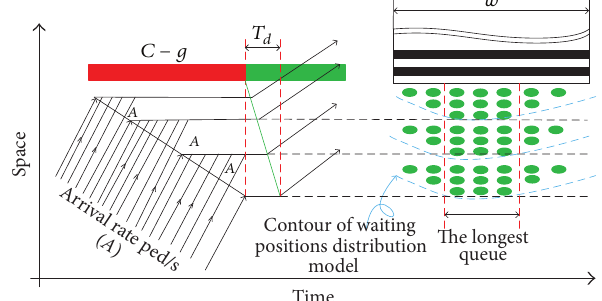
Figure 6: Pedestrian waiting and clearance